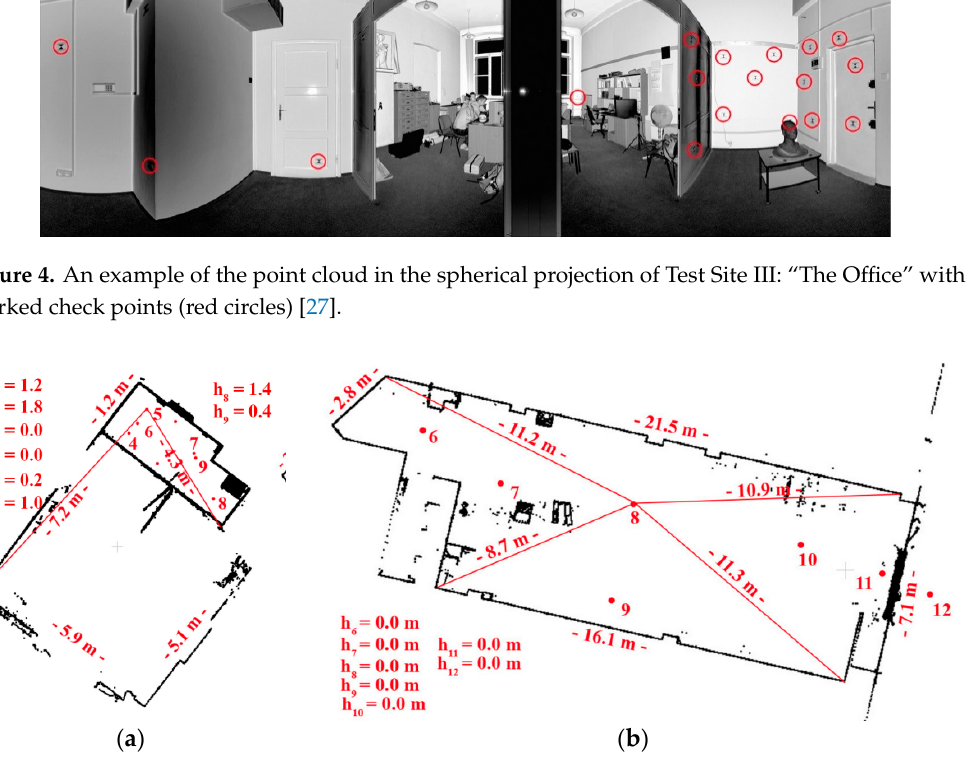
Figure 5. The floor plan with marked TLS scanner position with distances to the nearest walls for: ( a ) Test Site III: “The Office” and ( b ) Test Site IV: “Empty Shop (shopping mall)”. The high point of each TLS station related to the reference scan was presented in figures. The ‘h’ values are related to the high point of the reference scan [27].